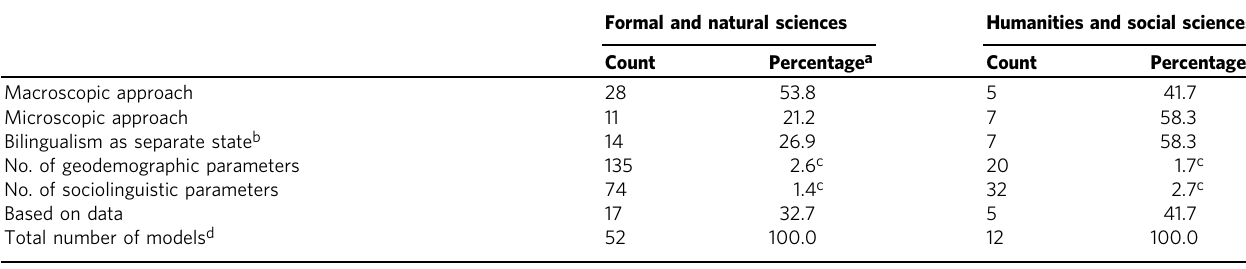
Table 4 Overview of models characteristics with respect to the discipline covered by the journal of